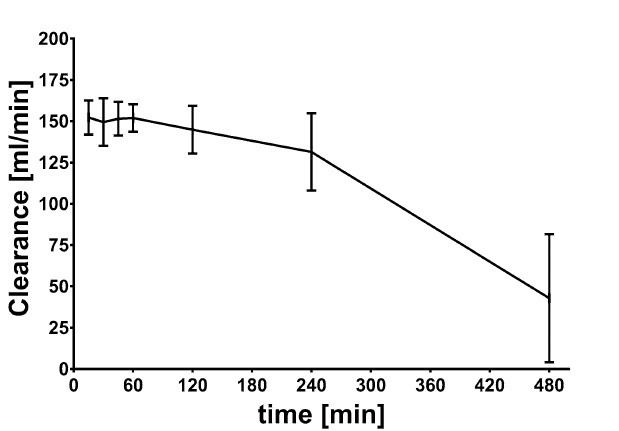
Figure 1. Fosfomycin serum levels in 10 patients during slow-extended dialysis. Squares show serum levels in patients after the first application of fosfomycin (5 g). Circles show serum levels in patients with ongoing therapy, after at least two doses of fosfomycin (5 g) (data from 10 patients, mean ± SD). (Figure created with GraphPad PRISM, version 7.05, www. graph pad. com).